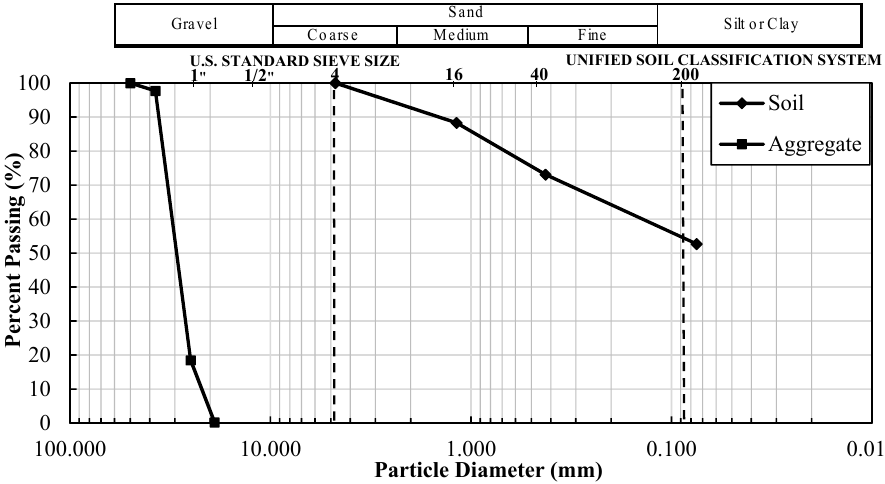
Figure 1. Native soil and aggregate particle size distribution.